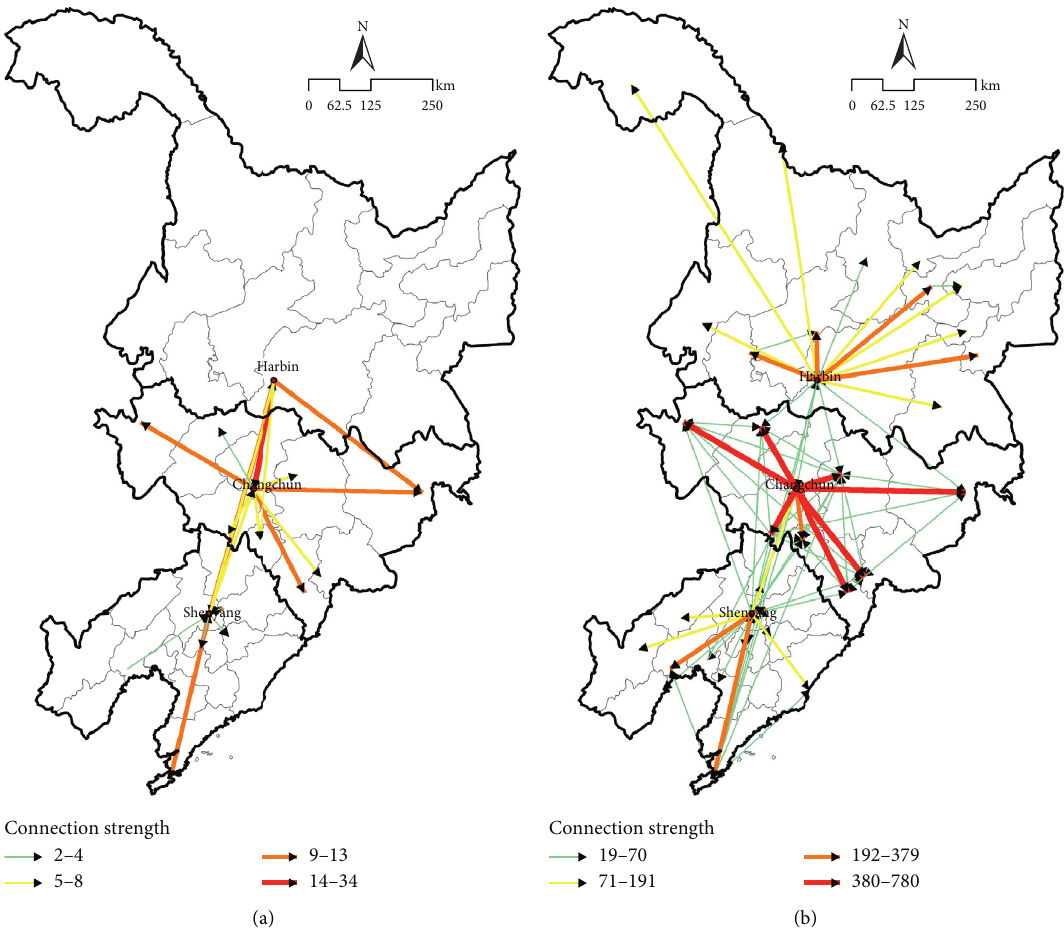
Figure 3: Spatial connection pattern of regional networks. (a) Central projects. (b) Local